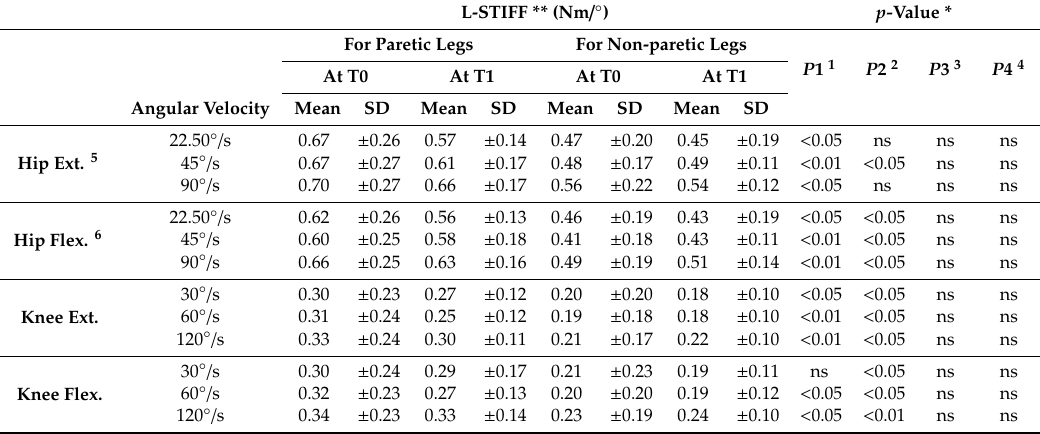
Table 2. Mean and standard deviation (SD) of the L-STIFF measures (Nm / ◦ ) for paretic and non-paretic limbs at basal assessments (T0) and one-month follow-up